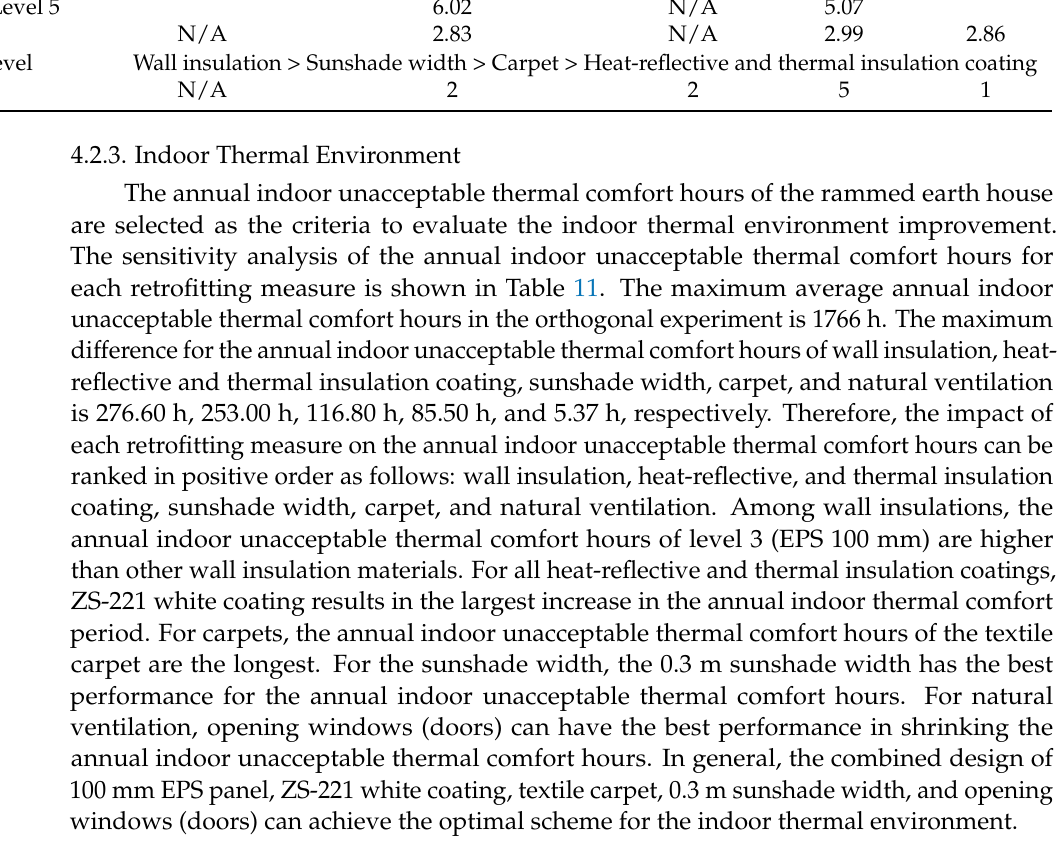
Table 11. Sensitivity analysis of the annual indoor unacceptable thermal comfort